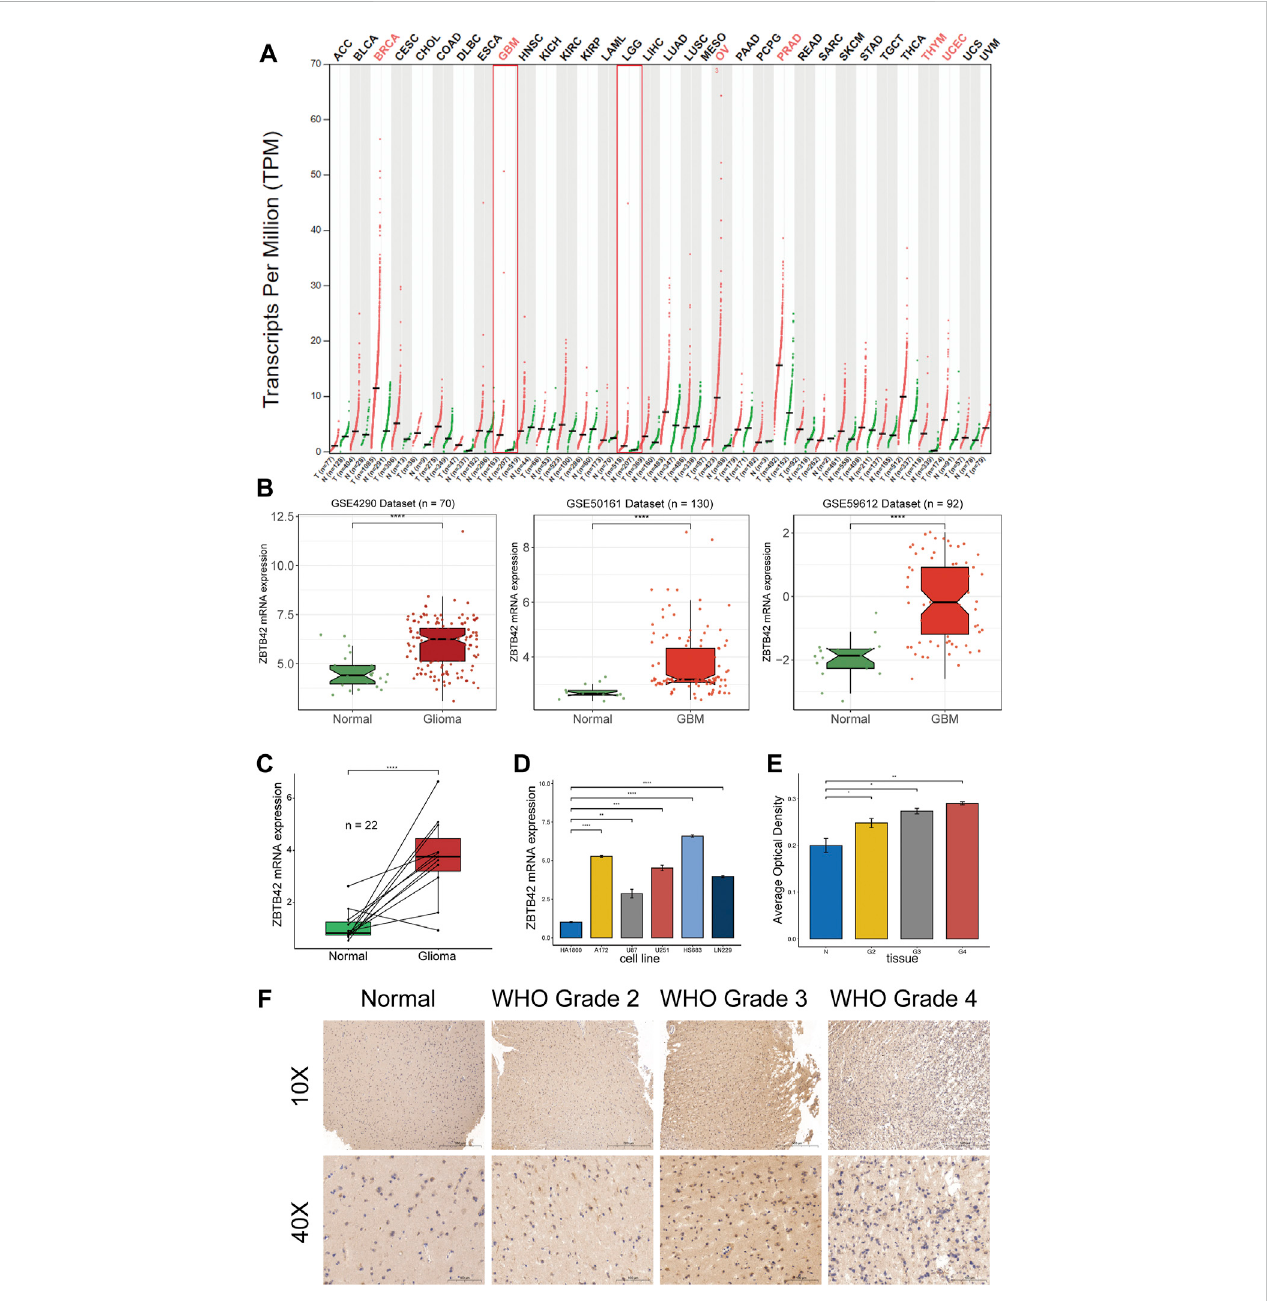
FIGURE 1 ZBTB42 expression pro fi le in pan-cancer and glioma. (A) ZBTB42 mRNA expression of pan-cancer in TCGA dataset. (B) ZBTB42 is highly expressed in glioma compared with normal tissue in three different GEO datasets. (C) ZBTB42 mRNA expression in normal brain and glioma tissues. (D) ZBTB42 mRNA expression in human glia cell line and different glioma cell lines. (E) Quanti fi cation of ZBTB42 IHC staining between different WHO grades of gliomas and normal tissues ( n = 12). (F) Immunohistochemistry staining of ZBTB42 in normal brain and glioma samples ( n = 12). * p < 0.05; ** p < 0.01; *** p < 0.001; **** p <